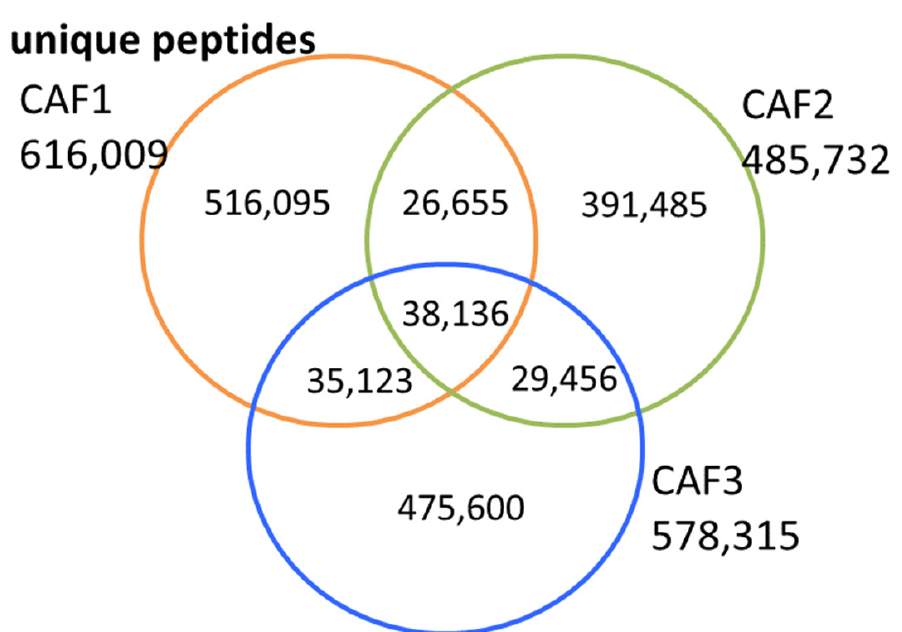
Figure 2. Venn diagram of three peptide selections on CAF cell line. Total numbers of unique peptide sequences of the NGS data derived from individual translated DNA sequences are given for each of the three CAF repertoires. The numbers inscribed within the circles reflect the unique sequences for each repertoire and the numbers of peptides in overlapping segments being observed, respectively, in two or three of the peptide selections.